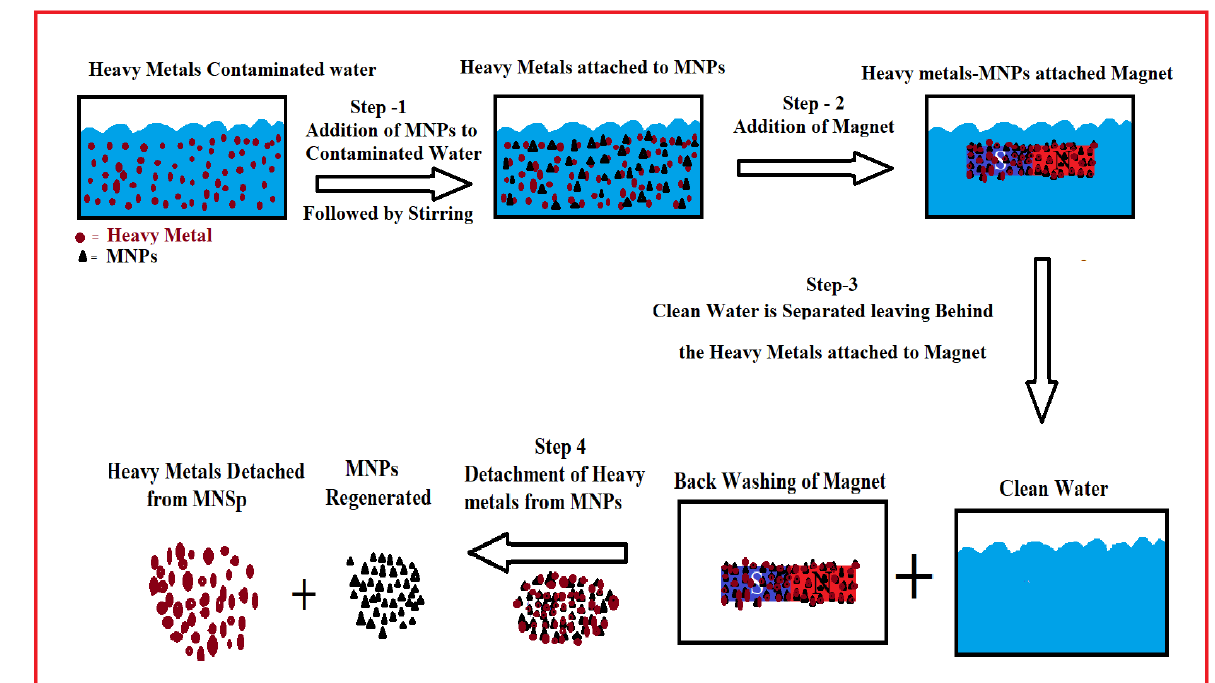
Figure 3. Schematic representation of the working steps for water cleaning using